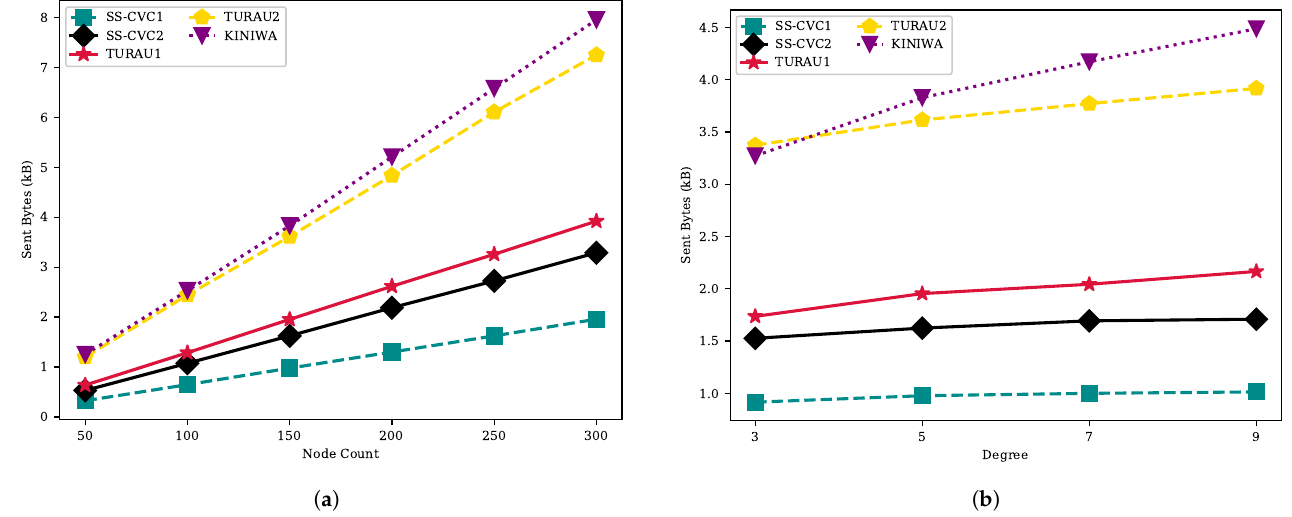
Figure 9. Sent bytes of algorithms on weighted networks: ( a ) Sent bytes against node count on the fixed average degree 5; ( b ) Sent bytes against node count on the fixed network size